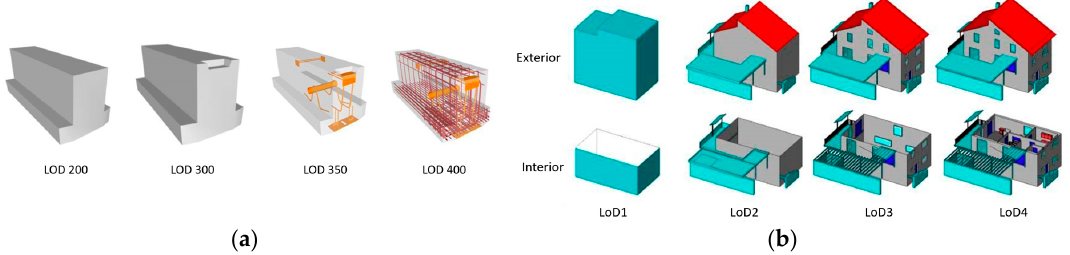
Figure 2. Different LODs in IFC for a precast structural inverted T beam (extracted from Figure 2. Di ff erent LODs in IFC for a precast structural inverted T beam (extracted from https://bimforum.org/lod/): ( a ) and LoDs for CityGML of a residential building ( b ) . https: // bimforum.org / lod / ) ( a ) and LoDs for CityGML of a residential building (courtesy of Karlsruhe Institute of Technology) ( b